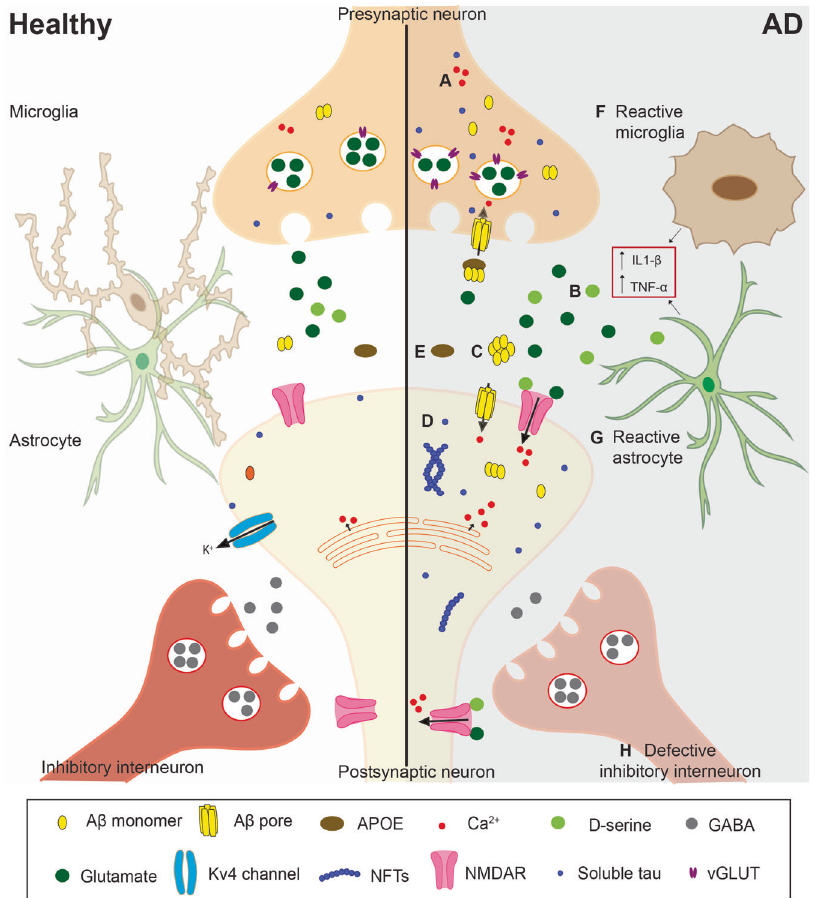
Fig. 1 Mechanisms causing neuronal hyperexcitability in Alzheimer ’ s disease. Representation of a synapse in the healthy (left) and in the AD (right) brain. A Increased release of calcium from intracellular stores from pre and postsynaptic neurons results in higher levels of cytosolic calcium. B Enhanced glutamatergic signaling can be caused by reduced astrocytic uptake, reduced levels of glutamine synthetase (not shown in the Figure), and/or increased vGLUT expression. C Amyloid- β can form ionic pores in the plasma membrane. It also reduces the expression of Kv4 channels and increases NMDAR activation via increased D -serine and glutamate release and reduced glutamate uptake. D Protein tau can contribute to hyperexcitability by altering glutamate levels as well as the expression and function of Kv4.2 channels and NMDAR. E Compared to apoE3, apoE4 reduces the clearance and uptake of A β 42 by astrocytes and microglia, respectively. F , G The release of pro- in fl ammatory cytokines, such as IL-1 β and TNF- α , by glial cells can promote hyperexcitability. F During gliosis, reactive microglia fail to properly regulate neuronal excitability. G In AD, astrocytes show increased release and reduced uptake of glutamate, as well as reduced expression of potassium channel Kir4.1 (not shown in the Figure). Reactive astrocytes also increase neuronal excitability by reducing synaptic inhibition. H Reduced fi ring frequency and the number of inhibitory GABAergic neurons is another contributing factor to hyperexcitability in AD. AD Alzheimer ’ s disease, NMDAR NMDA receptor, vGLUT vesicular glutamate NMDAR blocker MK-801 in AD mice reduced the frequency of neuronal fi ring in normal and hyperactive neurons, suggesting aberrant activation of this receptor is involved in hyperexcitability [27]. The use of the drug Memantine, which preferentially blocks extrasynaptic NMDAR, to treat moderate to severe AD in the clinic, supports the theory that synaptic NMDAR are required for neuronal survival, while extrasynaptic NMDAR mediate neurotoxi- city [62]. Consistent with this hypothesis, enhancing the synaptic glutamate NMDAR subunit epsilon-1 (GluN2A) with the positive allosteric modulator, GNE-0723, reduced network hypersynchrony and epileptic discharge and ameliorated memory de fi cit in an AD mouse model [61]. The authors speculated this could be a consequence of activation of GluN2A expressing interneurons, thus suppressing excitatory neuronal activity. However, further investigation is required to fully understand the mechanisms behind these results. In conclusion, several alterations in glutamatergic transmission are observed in AD, thus modulation of speci fi c NMDAR subunits poses a potential treatment strategy for hyperexcitability in AD.